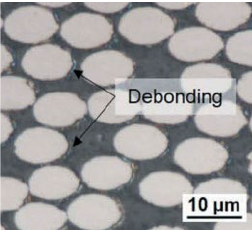
Figure 32. Interface debonding in the 45° ply. Reprinted with permission from [16], 2020, © Taylor & Francis.